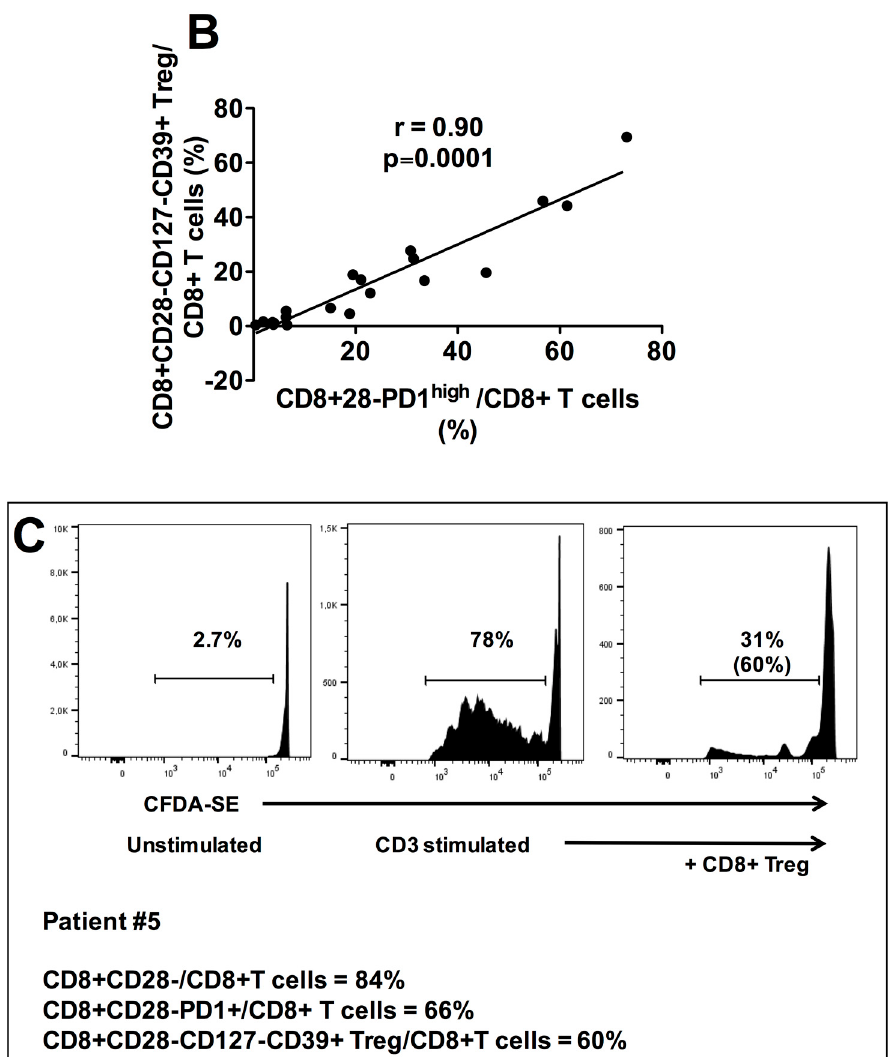
Figure 4. Relationship between tumor infiltrating CD8+CD28 − PD1 hi T cells and CD8+CD28 − CD127 − CD39+ Treg in HNSCC patients. ( A ): Mean frequencies of CD8+CD28 − CD127 − CD39+ Treg among CD8+CD28 − PD-1 lo , CD8+CD28 − PD- 1 int and CD8+CD28 − PD-1 hi T cell subpopulations. Statistical significant differences are evidenced. ( B ): Statisti- cal correlation between the frequency of tumor infiltrating CD8+CD28 − PD-1 hi T cells and that of tumor infiltrating CD8+CD28 − CD127 − CD39+ Treg in our cohort of HNSCC patients. ( C ): Proliferation suppression assay performed with the CD8+ T cell infiltrate from the representative patient #5 containing comparable frequencies of CD8+CD28 − PD-1 hi (66%) and CD8+CD28 − CD127 − CD39+ Treg (60%). The percentages of T cell proliferation under unstimulated conditions (left panel) or anti-CD3 UCHT1 mAb–stimulated conditions in absence (middle panel) or presence (right panel) of tumor infiltrating CD8+CD28 − CD127 − CD39+ Treg (CD8+ Treg in the Figure) are shown; the percentage of proliferation inhibition by CD8+CD28 − CD127 − CD39+Treg is shown in parentheses in the right panel. One out of two concordant experiments performed with cells of different